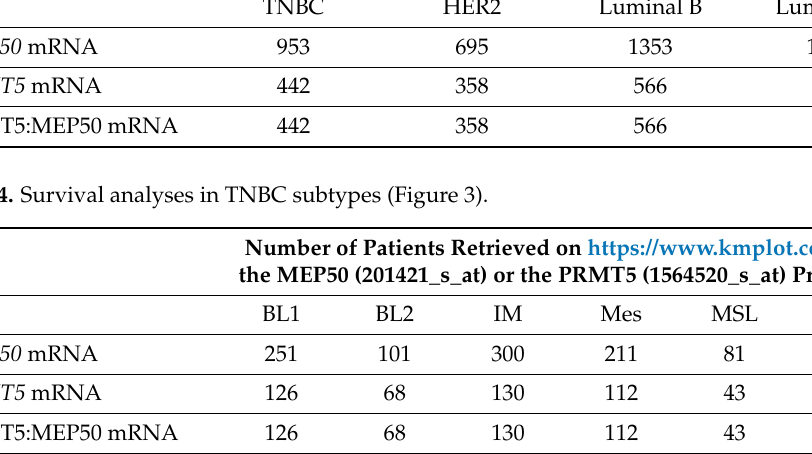
Table 3. Survival analyses in the breast cancer subgroups (Figure 2). Number of Patients Retrieved on https://www.kmplot.com with the MEP50 (201421_s_at) or the PRMT5 (1564520_s_at) Probe Sets